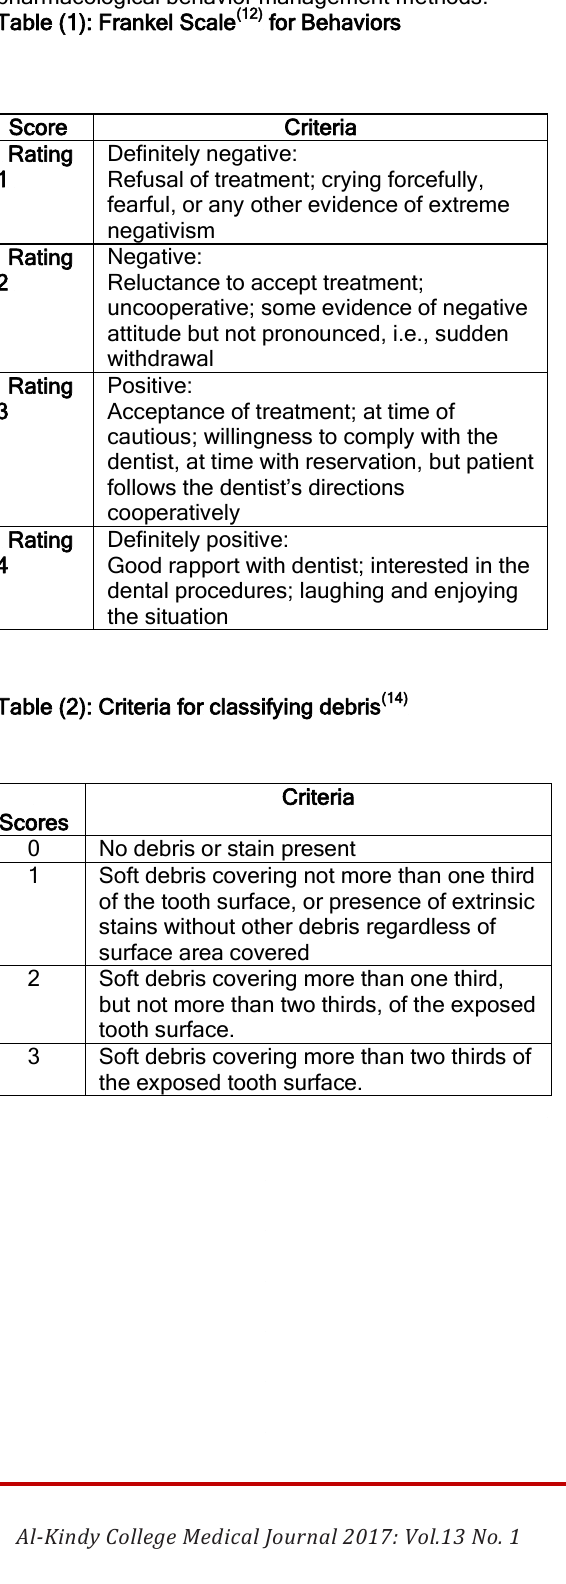
Table (1): Frankel Scale (12) for Behaviors